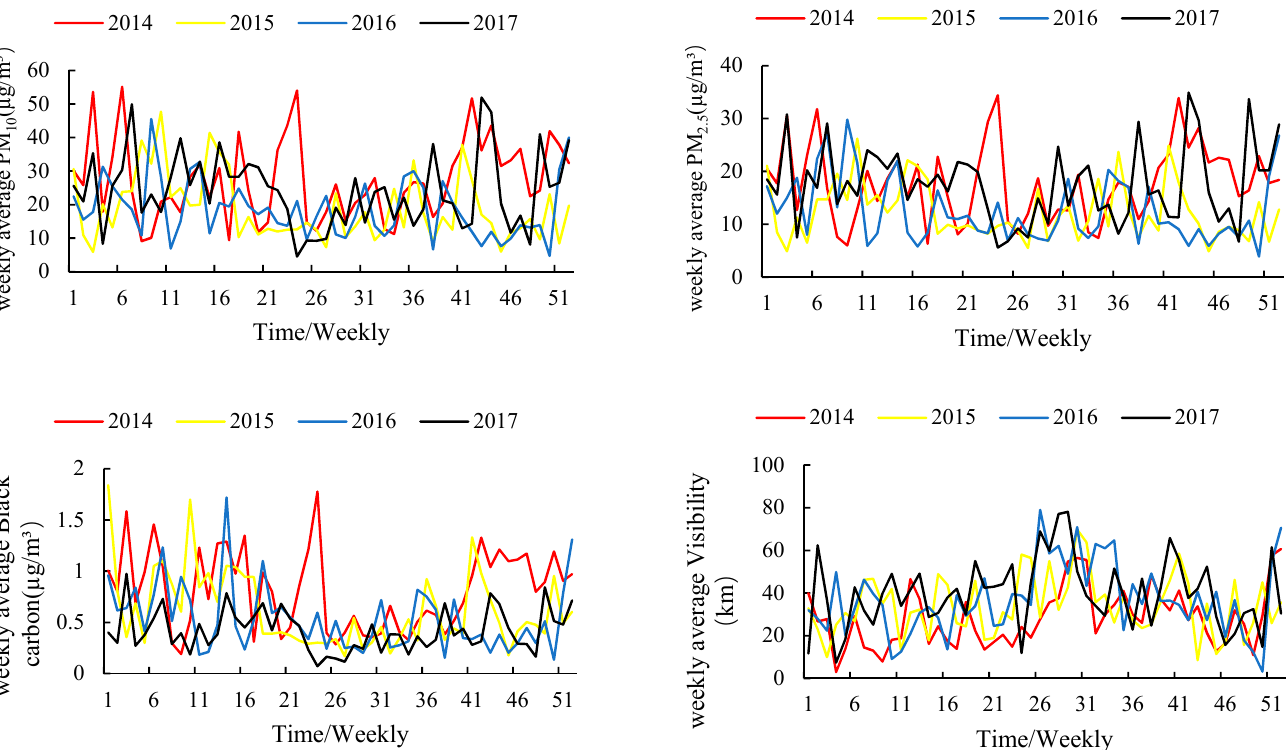
Figure 3. Weekly averages for SO 2 , NO 2 , CO, PM 10 , O 3 , PM 2.5 , and black carbon concentration, visibility from 2014–2017.